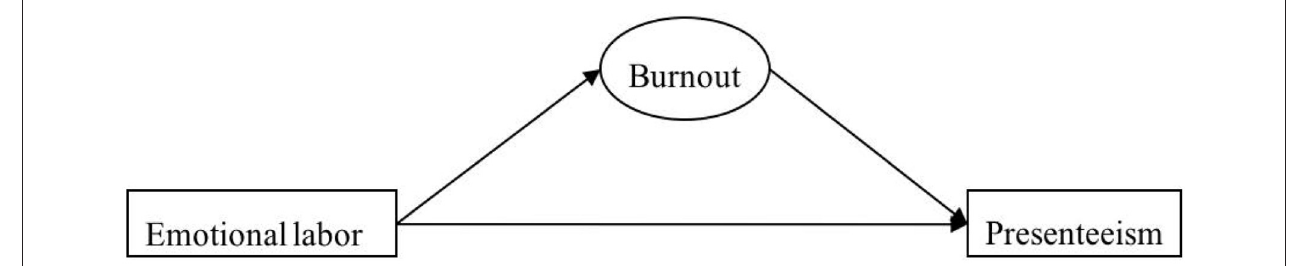
FIGURE 1 | The hypothesized